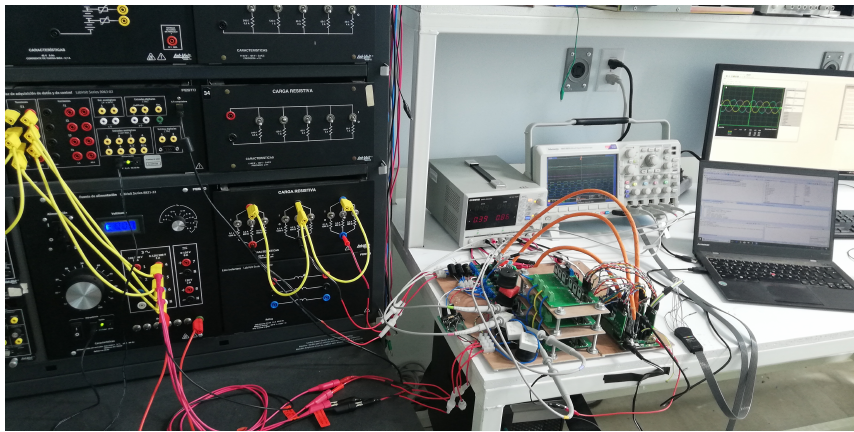
Figure 10. System implementation for testing